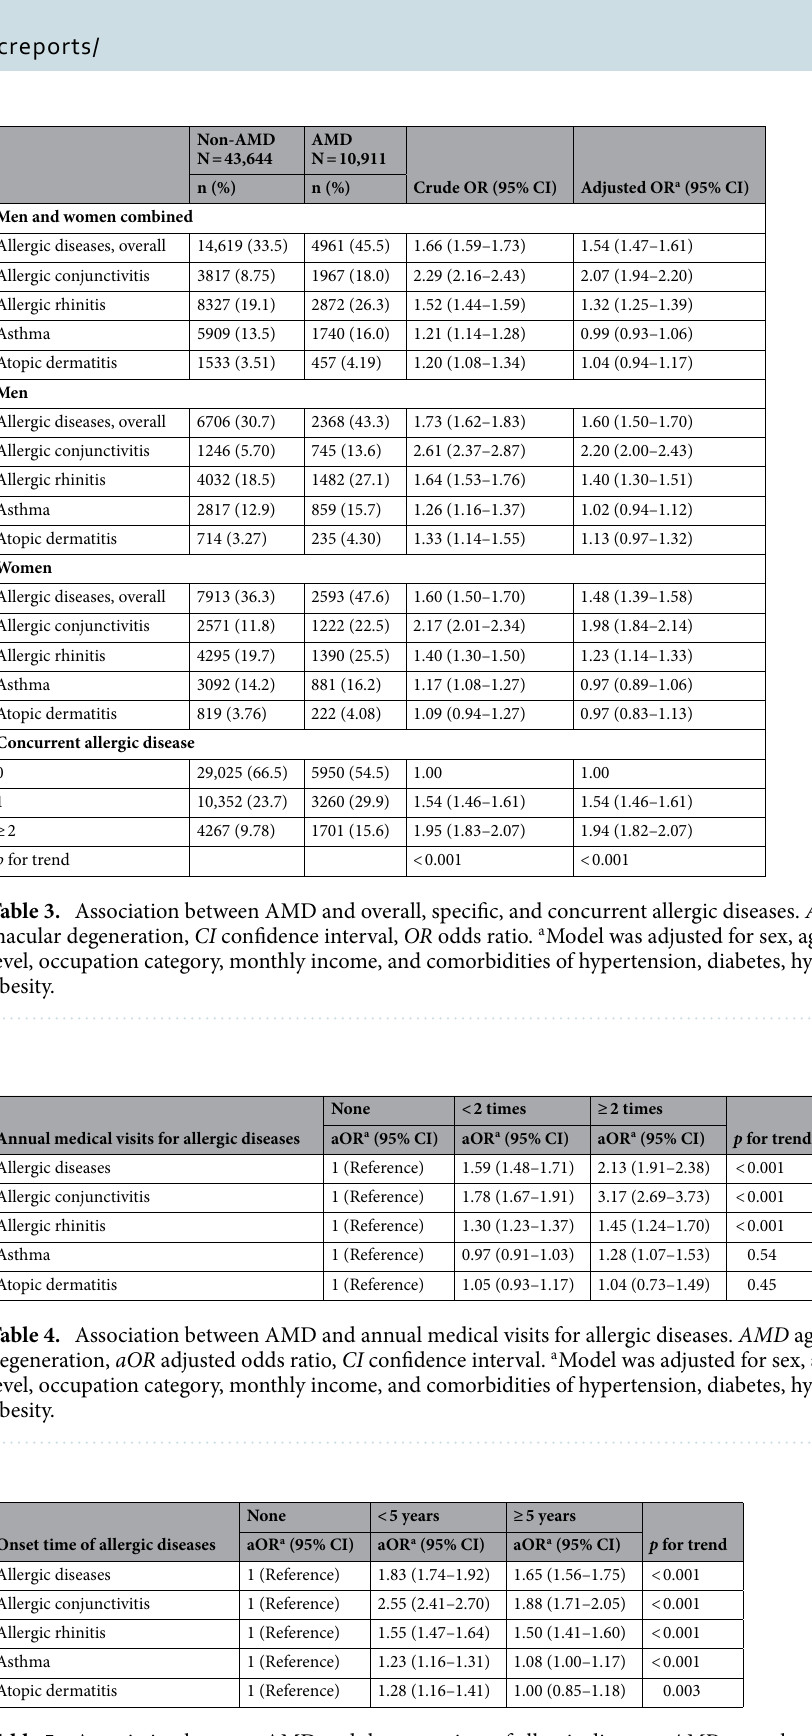
Table 5. Association between AMD and the onset time of allergic diseases. AMD age-related macular degeneration, aOR adjusted odds ratio, CI confidence interval. a Model was adjusted for sex, age, urbanization level, occupation category, monthly income, and comorbidities of hypertension, diabetes, hyperlipidemia, and